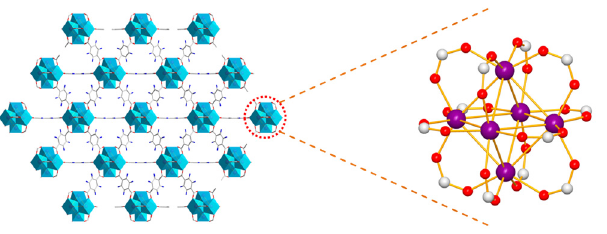
Figure 2. Schematic diagram of the internal structure of UiO-66. Purple, red, and white represent Zr, O, and C, respectively.